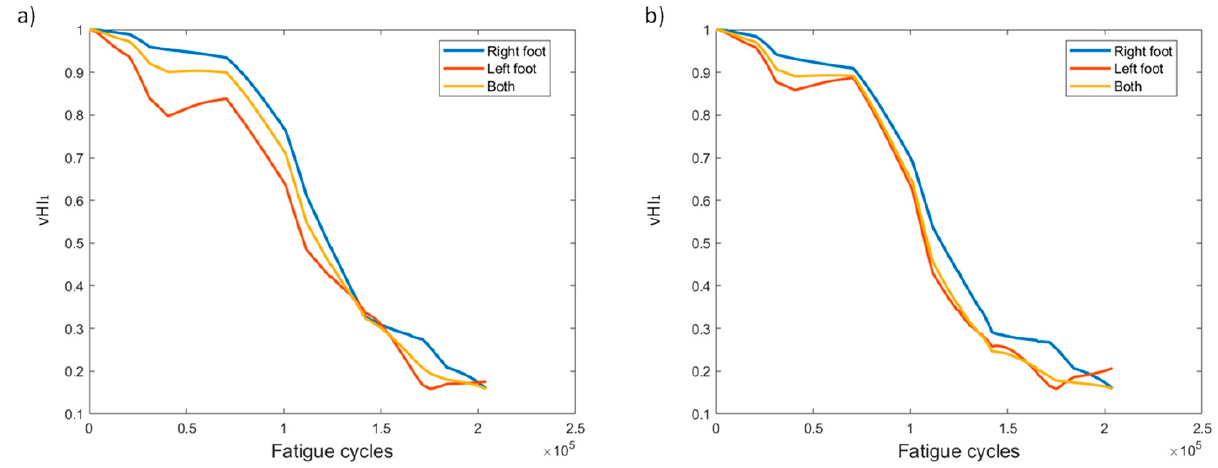
19 of 26 Figure 16. HI 3 progression through time for the two pre-processing methods for specimen VA-1: ( a ) method 1, ( b ) method 2. Similar trends can be observed between HI 3 and HI 4 (Figure 17). Increasing overall values during the specimen’s lifetime with method 1 display a slightly smoother increase. Method 2 leads to lower HI values for the first time, a fact attributed to the effect of sensor R5, which for HI 2 shows the highest monotonicity, and hence has the largest effect in the fusion, yet shows significantly lower values than its method 1 counterpart. However, this does not affect the overall performance of H 4 , which is quite promising. Figure 17. HI 4 progression through time for the two pre-processing methods for specimen VA-1: ( a ) method 1, ( b ) method 2. VHI 1 displays a gradually decreasing behavior from 1 to 0.2 (Figure 18). Again, using